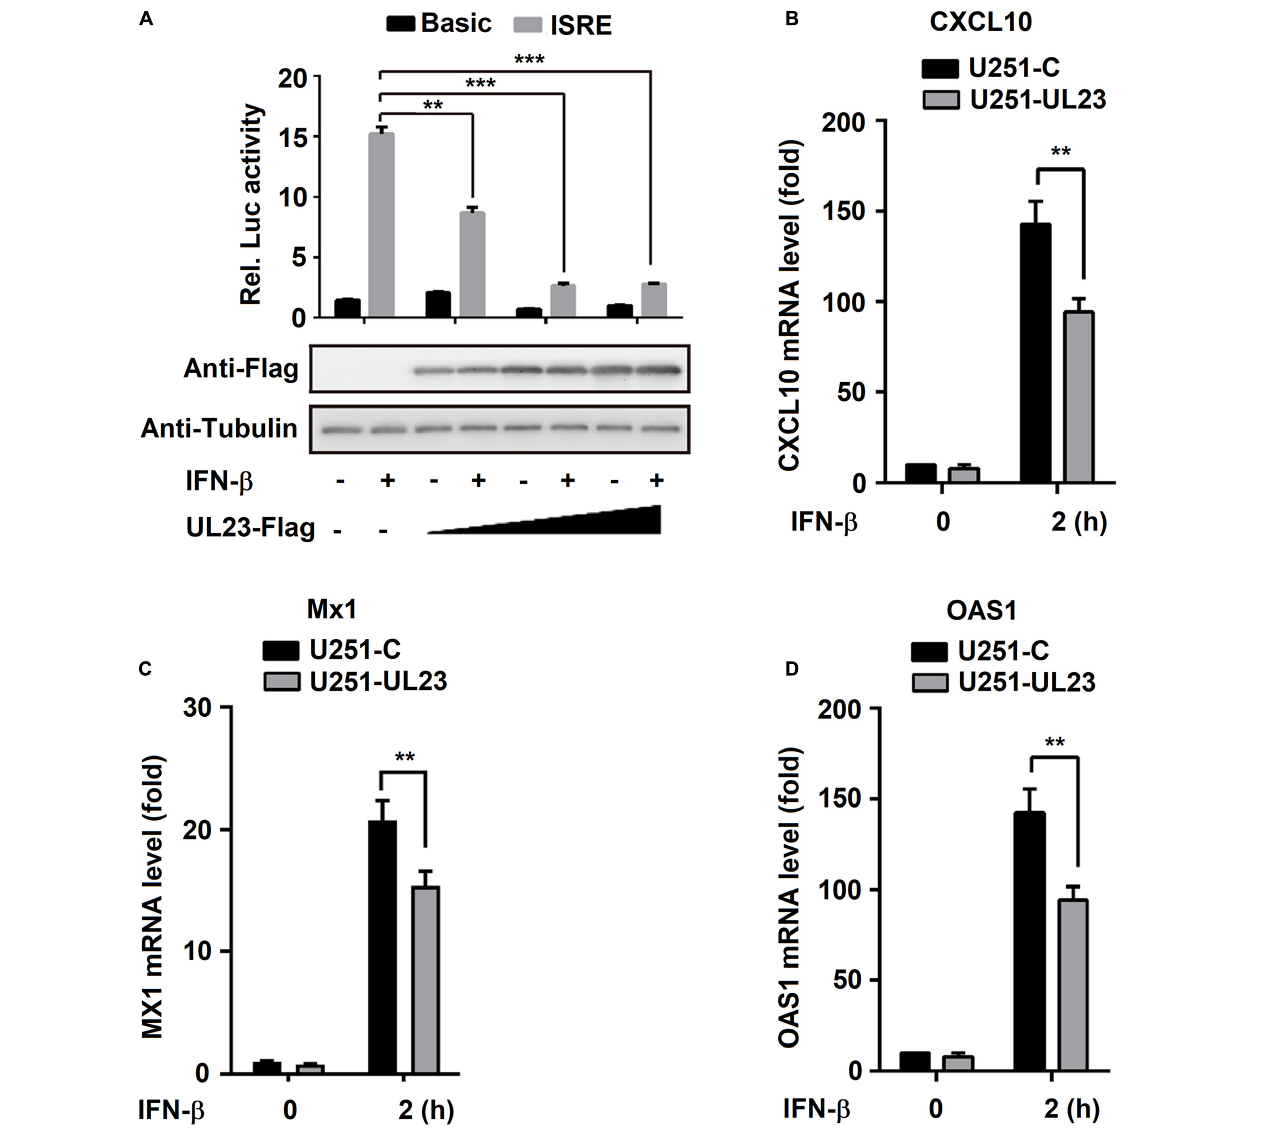
FIGURE 3 | Inhibition of IFN- β induces transcription by ectopic expression of UL23. (A) pRL-TK reporter or ISRE-Luc reporter was cotransfected into HEK293T cells with UL23 expression plasmid or empty vector. After transfection for 46 h, IFN- β (100 U/ml) was used to treat cells for 2 h or not treated, and then, luciferase activity was measured luminometrically by using the Dual-Luciferase reporter assay as relative light units. UL23 expression was measured through WB assay, with Tubulin as the loading reference. (B–D) qRT-PCR analysis of (B) CXCL10 , (C) MX1 , and (D) OAS1 expression in U251-C and U251-UL23 cells stimulated with 100 U/ml IFN- β for the indicated time points. Data are shown as mean ± SD. * p < 0 . 05, ** p < 0 . 01, *** p < 0 . 001 (unpaired, two-tailed Student’s t -test). Data are representative of three independent experiments with similar